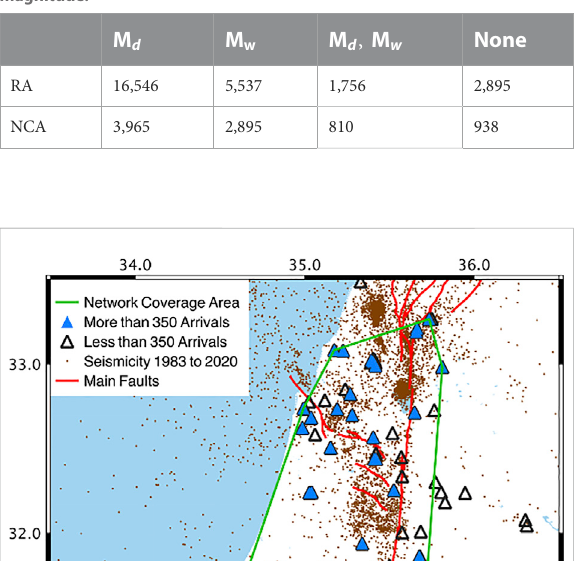
TABLE 1 The number of M d and M w magnitudes, determined for the investigated catalogue. The right-most fi eld is for events that contain no magnitude.